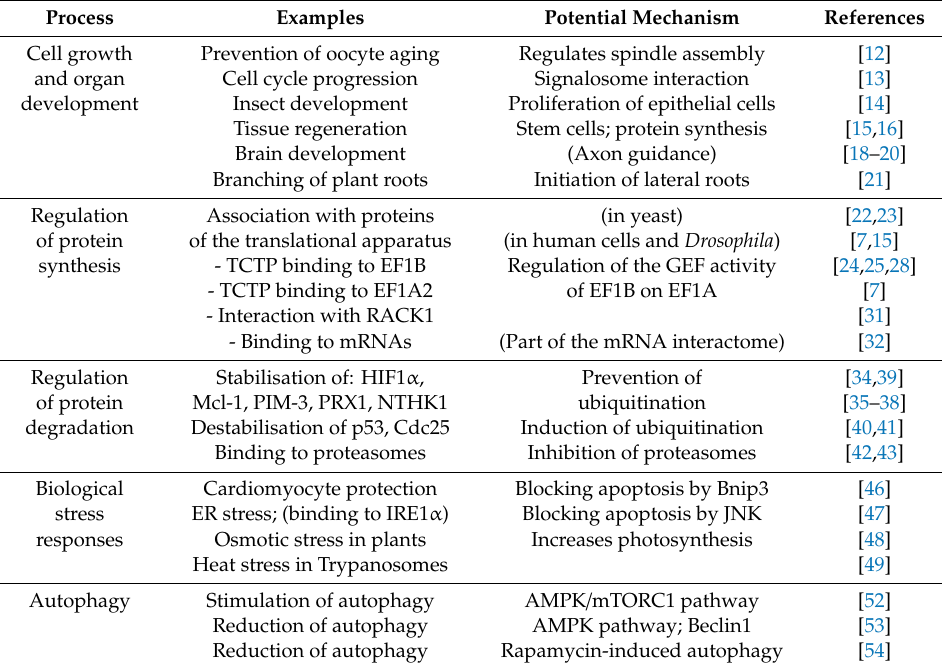
Table 1. The importance of TCTP in basic biological